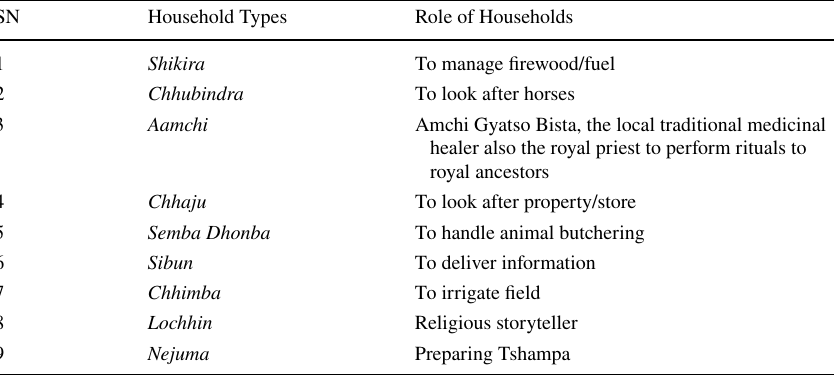
Table 2 Rotational division of labor of dhongba to serve the royal family in Lo Kingdom